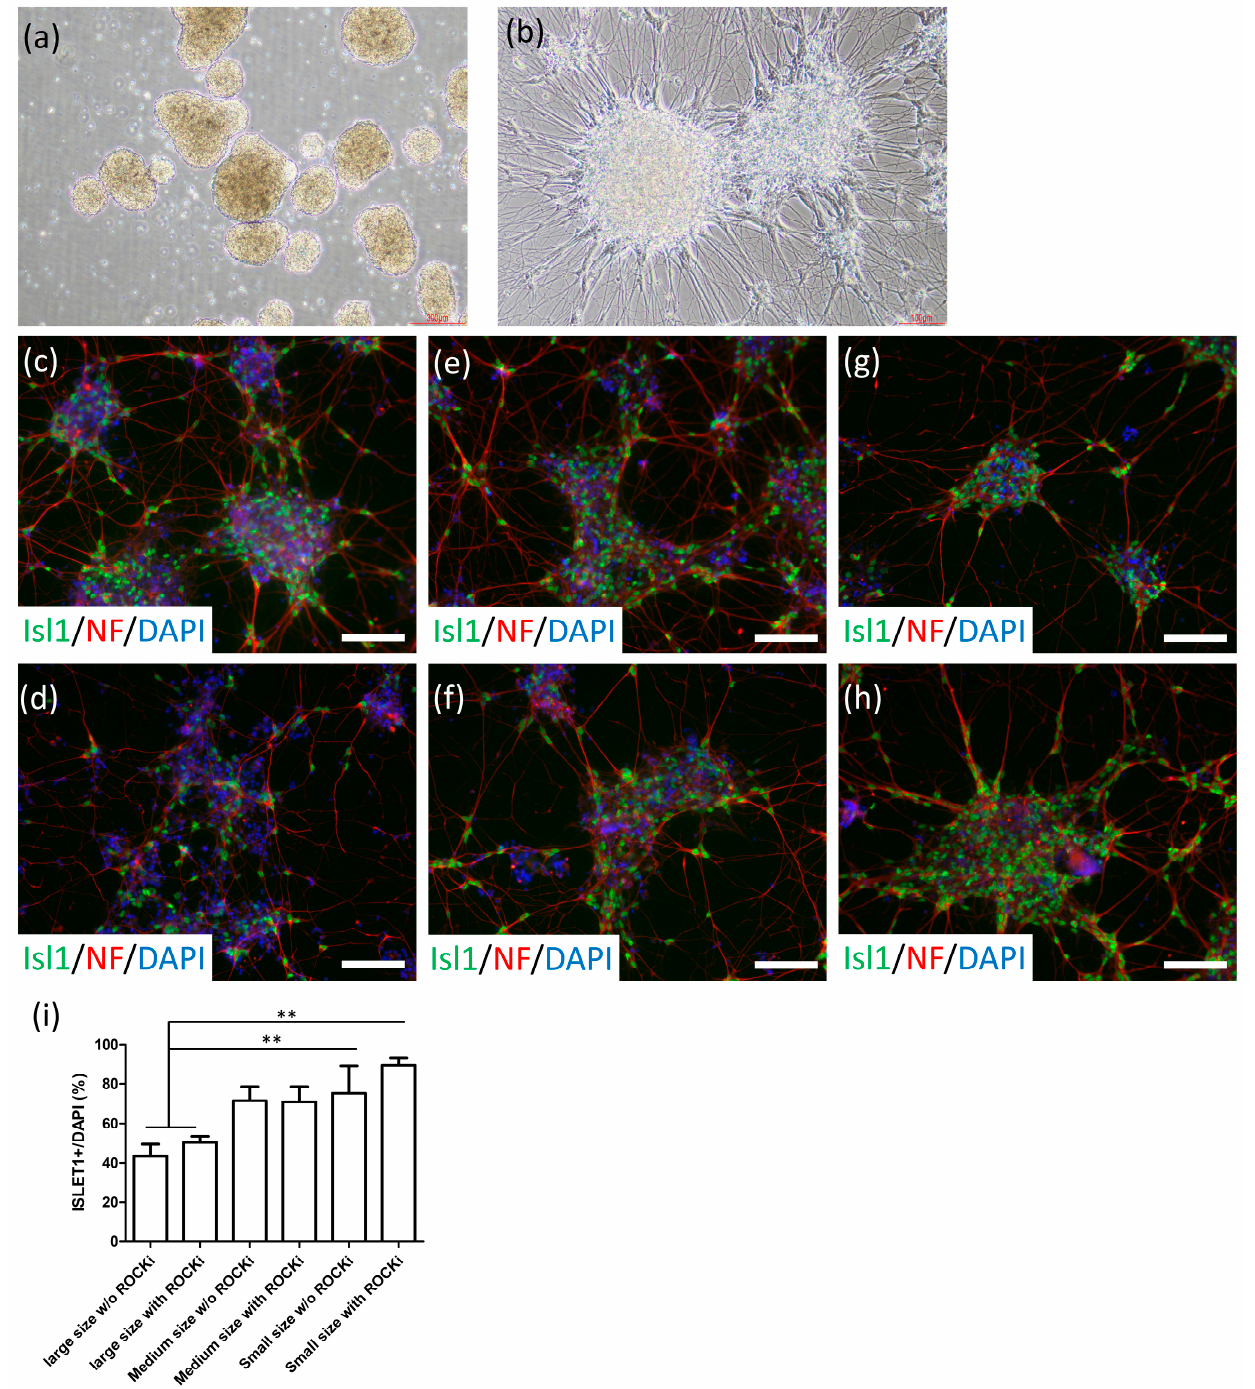
Figure 3. Cryopreservation and thawing of MNs on day 32. ( a ) Morphology of MN spheres after 24 h of thawing. ( b ) Morphology of adherent MNs after 4 days of thawing. ( c – h ) MN marker Islet1 (Green) and neuronal marker NF (Red) expression in DAPI + cells (Blue) after 4 days of thawing with >500 μ M EB without ROCK inhibitor treatment ( c ), >500 μ M EB with ROCK inhibitor ( d ), 300–500 μ M EB without ROCK inhibitor treatment ( e ), 300–500 μ M EB with ROCK inhibitor treatment ( f ), 200–300 μ M EB without ROCK inhibitor treatment ( g ), and 200–300 μ M EB with ROCK inhibitor treatment ( h ). ( i ) Calculation of the Islet-1 expression ratio of DAPI + cells. ** p < 0.01. Scale bar, 100 μ m. To determine the maturation status and electrophysiological function of the thawed MNs, cells were subjected to ICC, single-cell patch-clamp, and calcium imaging. After 1